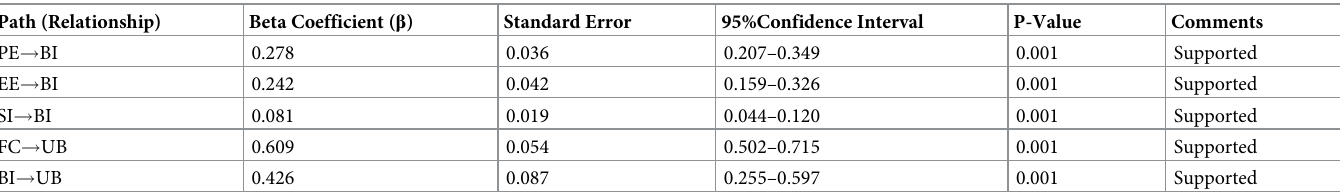
Table 4. Results of testing of the pathways in the